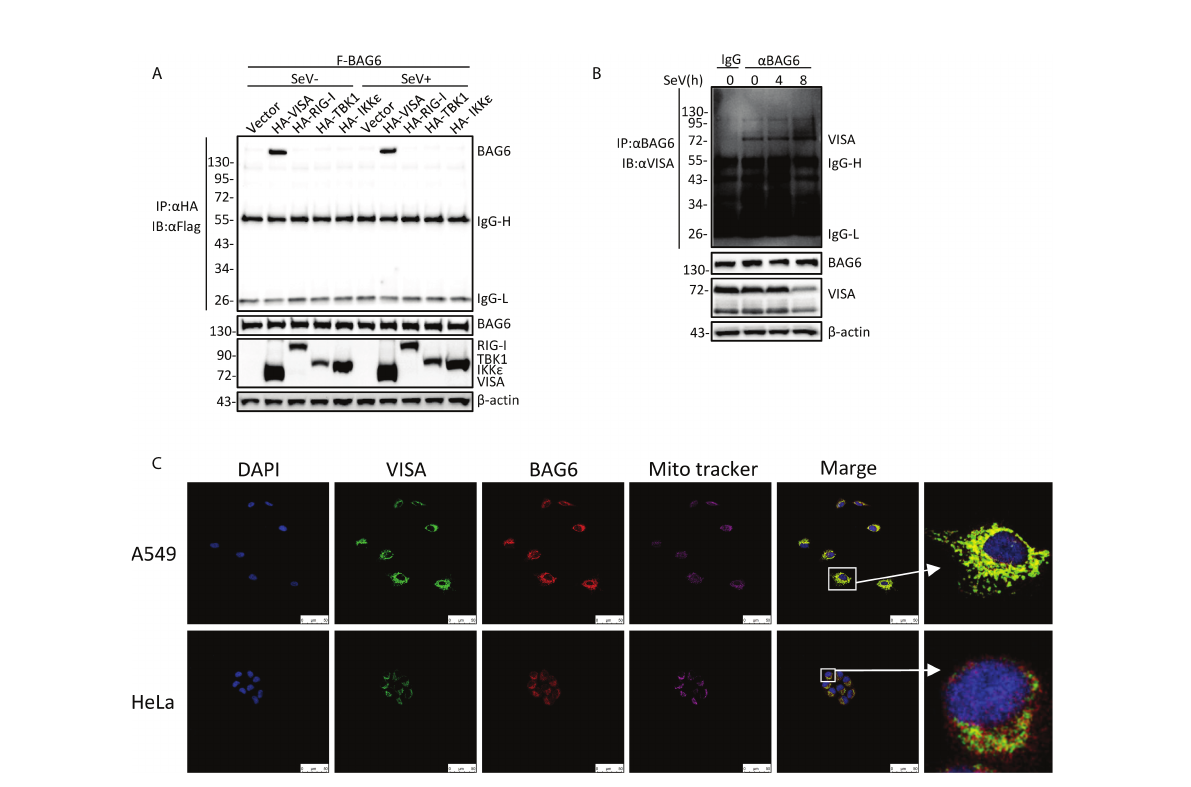
FIGURE 1 BAG6 interacts with VISA speci fi cally. (A) BAG6 interacts with VISA. HEK 293 cells (2×10 6 ) were transfected with indicated plasmids. 12 h after transfection, the cells were infected with SeV (MOI = 1) for 12 h or left untreated before co-immunoprecipitation and Western bolt analysis. (B) Endogenous BAG6 is associated with VISA. HEK 293 cells (2×10 7 ) were infected with SeV (MOI = 1) for indicated times or left untreated before endogenous co-immunoprecipitation and Western bolt analysis. (C) A549 or HeLa cells were incubated with anti-VISA (green) and anti-BAG6 (red) antibodies. Mitochondria were stained with Mito-tracker Red CMXRos, and Nuclei were stained with DAPI. Images were acquired with a Leica DMI8 and Leica LAS X software. The size bar represents 50 m